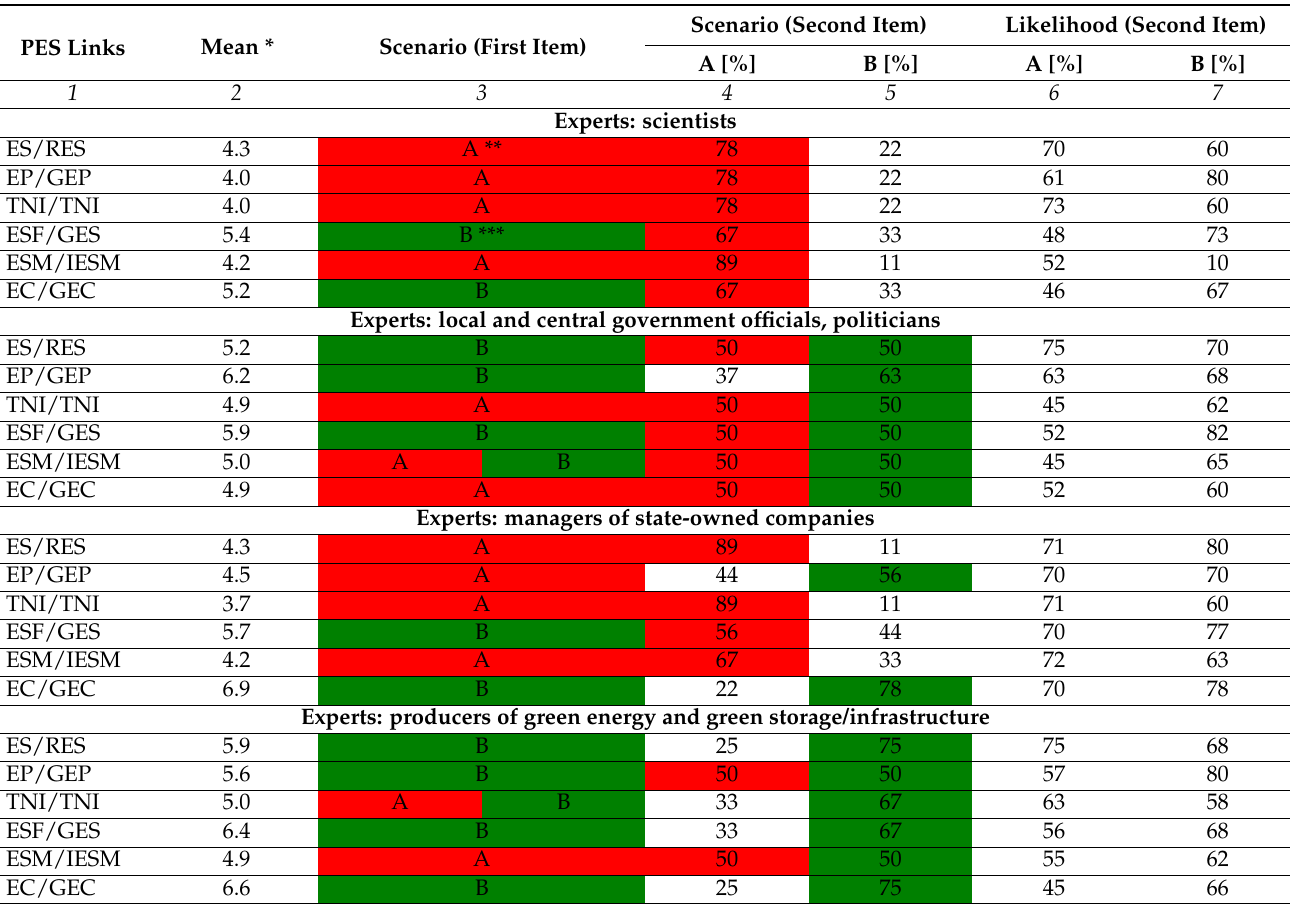
Table 4. Distribution of expert